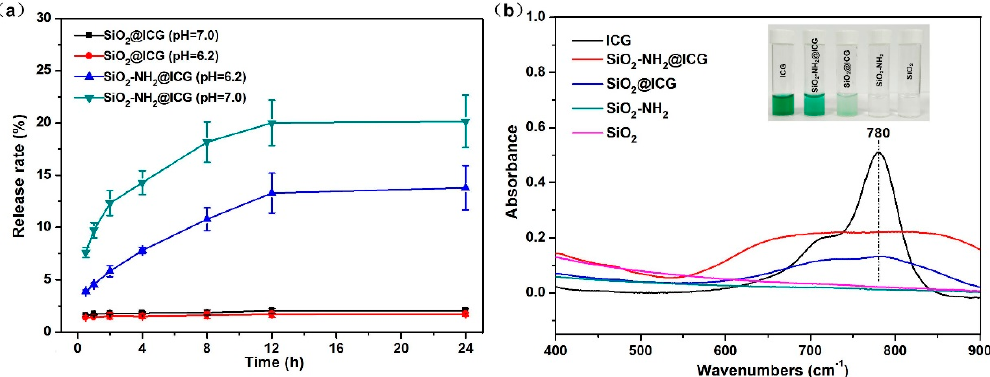
Figure 4. ( a ) Release behavior of ICG from the SiO 2 @ICG NPs and SiO 2 -NH 2 @ICG NPs in PBS (pH = 6.2 or pH = 7.4); ( b ) UV–vis spectra of ICG, SiO 2 -NH 2 @ICG, SiO 2 @ICG, SiO 2 -NH 2 and SiO 2 NPs in